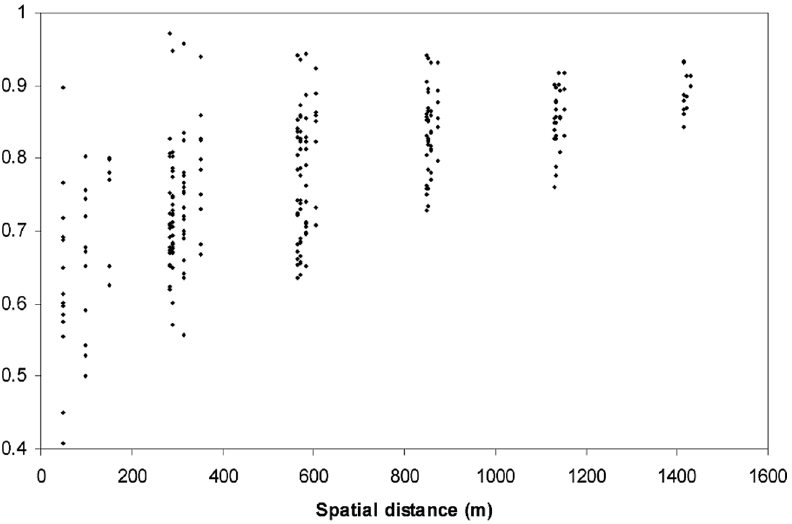
Figure 2. Distance-decay relationships in the non-continuous permafrost soils of the 1000 m altitude gradient. Pairwise dissimilarities (Bray-Curtis index) of microbial communities were plotted as a function of the distance (vertical plus horizontal) between the sampling locations.